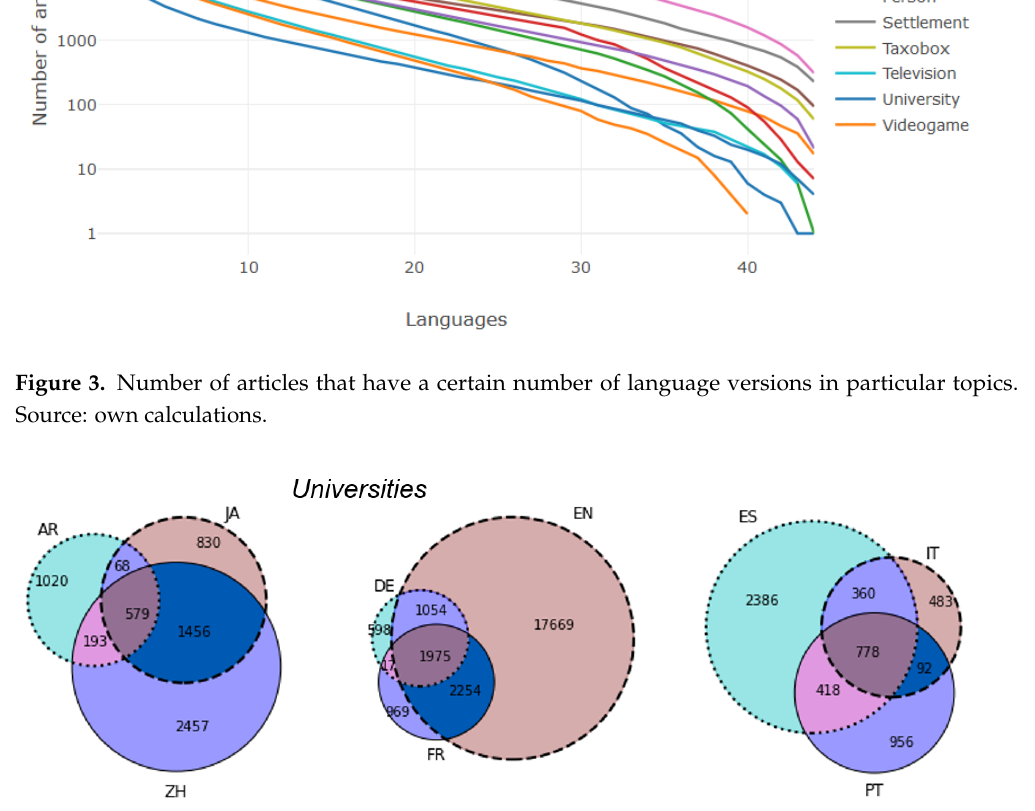
Figure 4. Coverage of articles that describe universities in different languages. Source: own